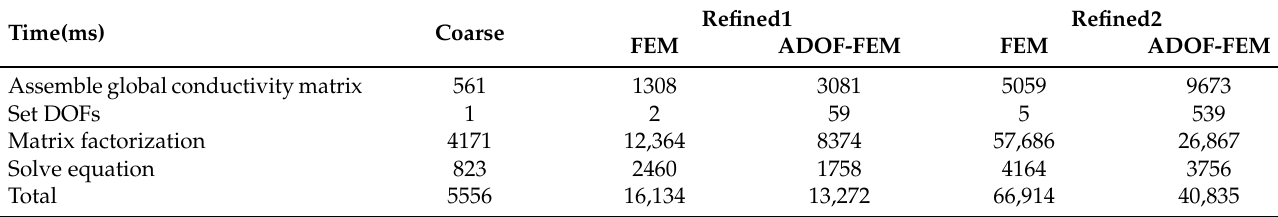
Table 1. The computational time of Example 1 (Unit: